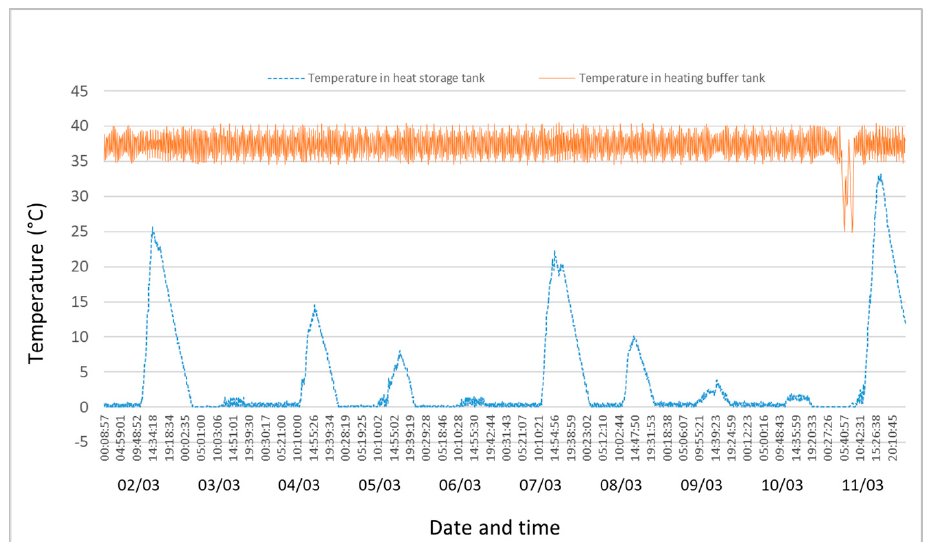
Figure 4. Water temperature in the heat storage tank and the heating buffer tank between March 2